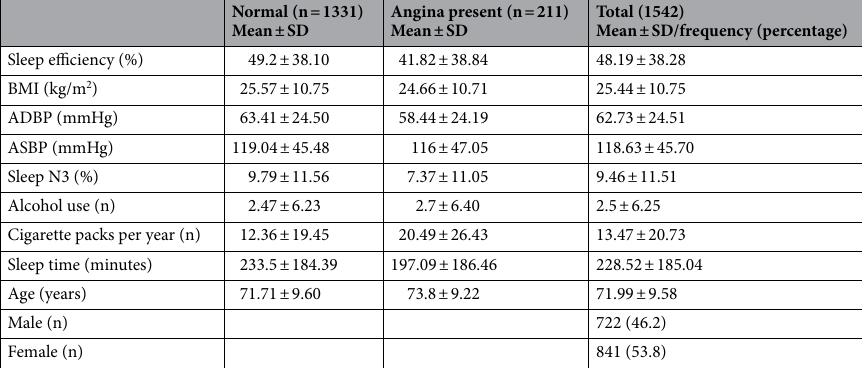
Table 1. Descriptive statistics for participant’s characteristics and dependent and independent variables (total n = 1563, missing data n = 21). BMI: body mass index; SD: standard deviation; ADBP: average diastolic blood pressure; ASBP: average systolic blood pressure; Sleep N3: percent time in stage N3 of